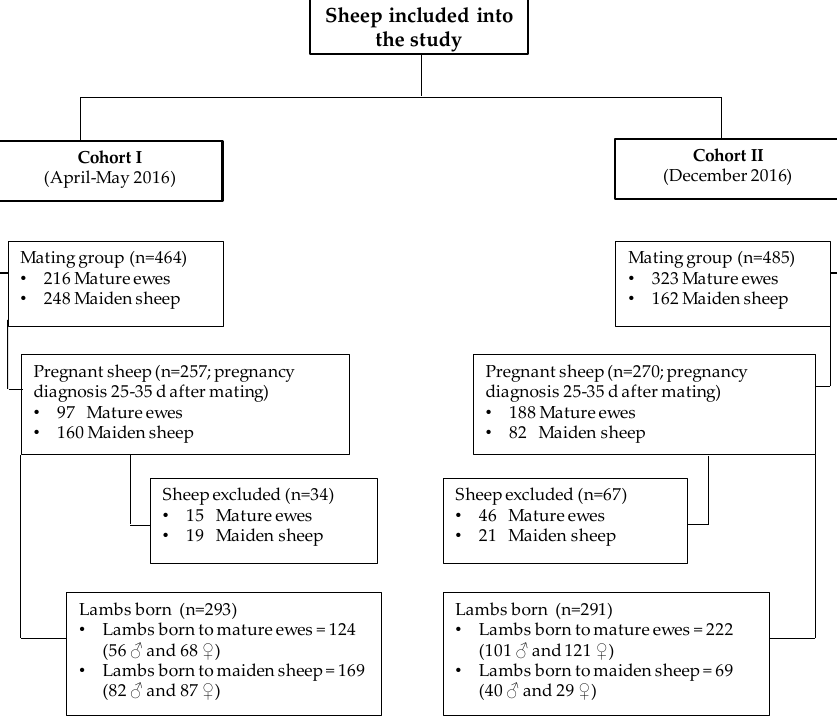
Figure 1. Flow chart of sheep included in the study.